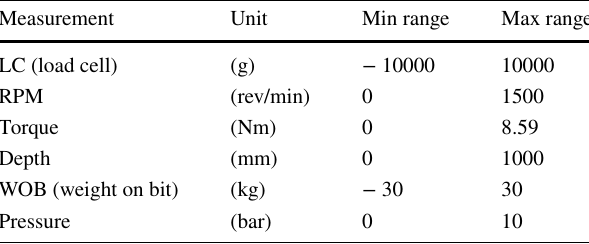
Table 1 Sensor measurement